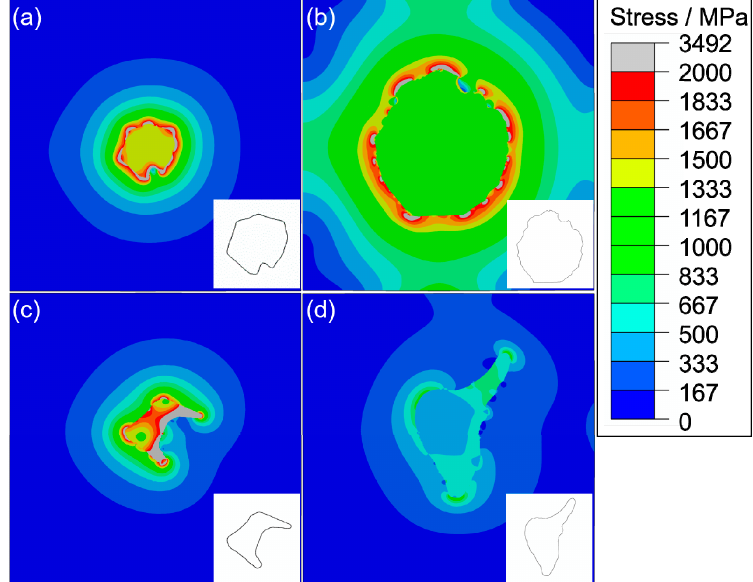
Figure 6. Residual stress distributions around the inclusions with their actual shapes: ( a ) Mg-Al-O; ( b ) Al-Ca-O-S; ( c )TiN; ( d ) MnS. ( b ) Al-Ca-O-S; ( c )TiN; ( d )